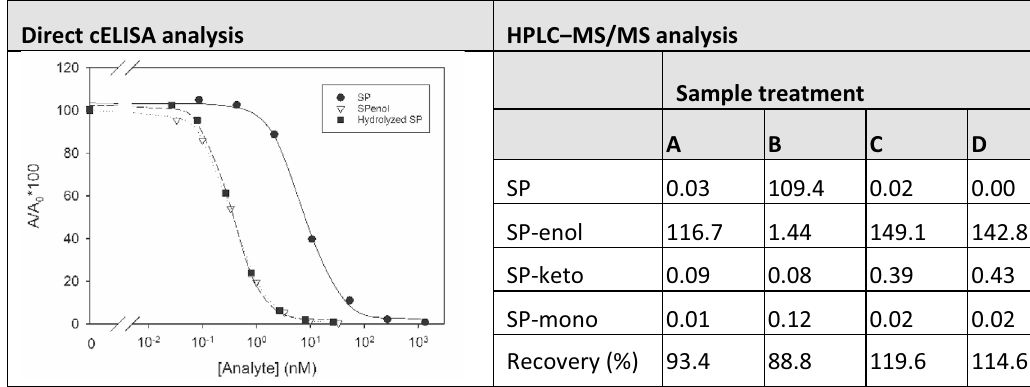
Table 2. Spirotetramat hydrolysis study by direct cELISA and HPLC ‒ MS/MS. A, SP hydrolysed; B, SP without hydrolysis; C, SP-enol hydrolysed; D, SP-enol without